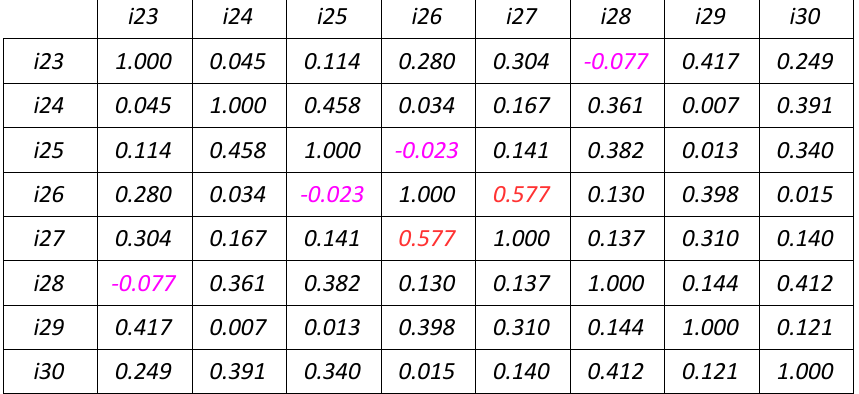
Table 4. Matrix of correlaton coefcients (Pearson, 2015) of the B4 competency. The